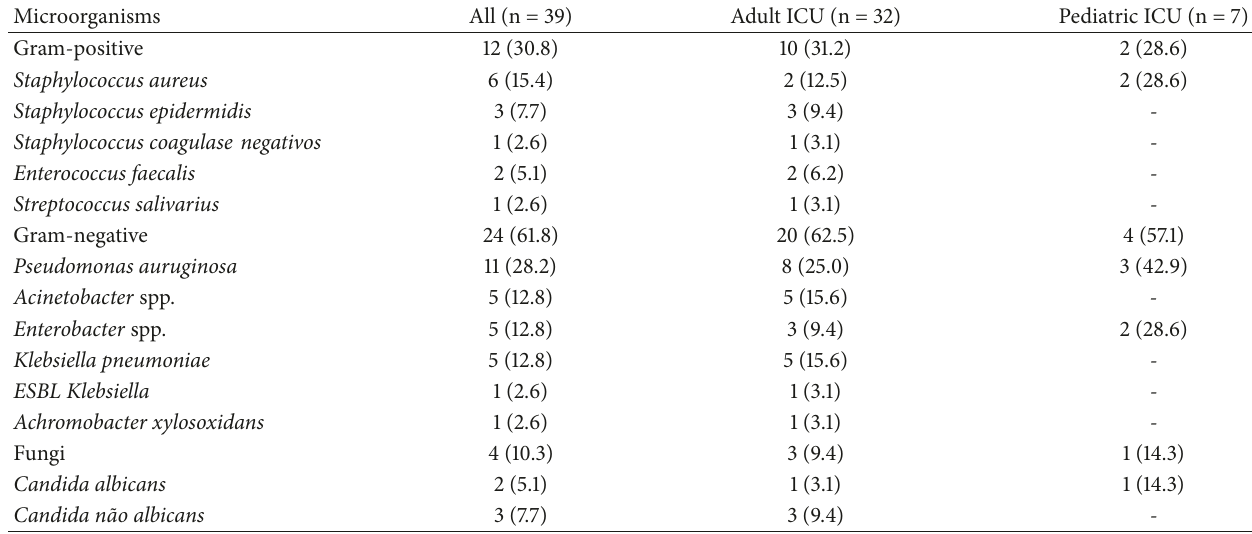
Table 5: Characterization of the microorganisms identified in culture for diagnosis of